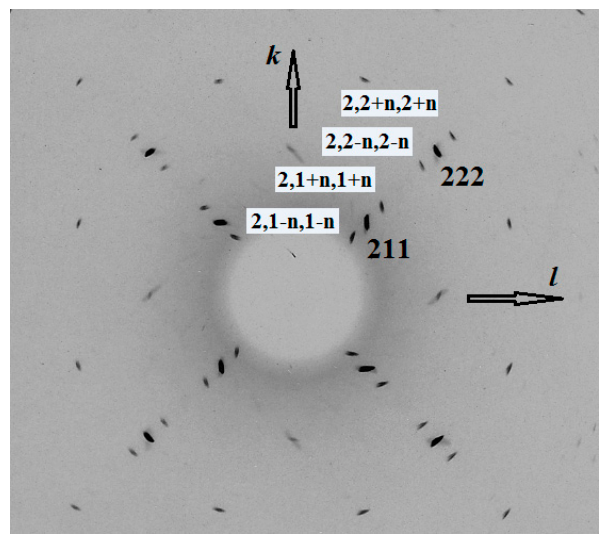
Figure 15. The (2 kl ) single-crystal X-ray diffraction photograph of the MD sample. Reflections corresponding to cubic pseudo-cell parameters and satellites are indicated.